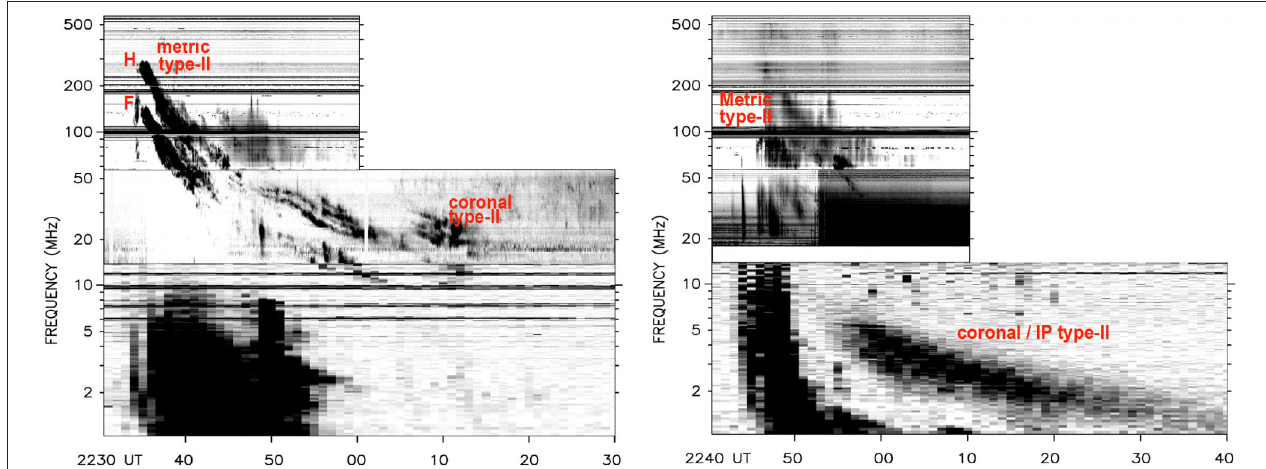
FIGURE 4 | Examples of type-II bursts in the low corona (“metric”) outer corona (“coronal”) and IP. Left : Composite spectrum on 2003 November 1. The WAVES data are below 14 MHz, the BIRS data run from 14 to 57 MHz, and the Culgoora data run from 57 to 570 MHz. Fundamental (“F”) and harmonic (“H”) bands of the type II are easily seen, along with band-splitting. A short, type II-like feature (“coronal”) is seen in the BIRS data between 23:06 and 23:14 UT. There is no indication of an IP counterpart. Right : The beginning of an IP type-II on 2003 June 17 22:40 UT. It is apparently unconnected to the metric type-II seen in the higher frequencies. Culgoora data are used between 18 and 57 MHz. Adapted from Cane and Erickson (2005). Reproduced by permission of the